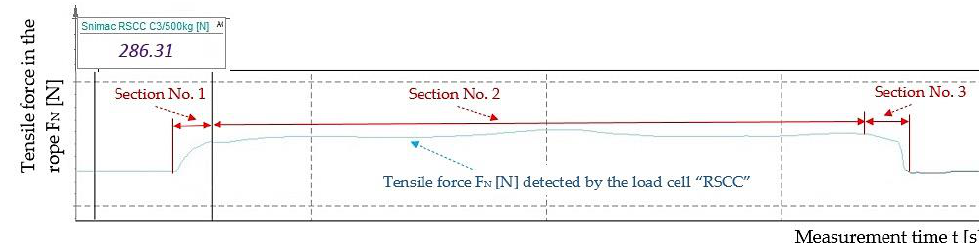
Figure 10. Pulling force waveform of F N measured by RSCC load cell on laboratory equipment. Experimental measurements of the generated pulling force in the cable were carried out on a measuring device (Figure 2) under the static condition of the pulley, i.e., the cable was not subjected to friction in the groove of the rotating pulley. The experimentally meas- ured F oMi forces listed in Table 3 to Table 6 were detected by an IMADA force meter with a measuring range of 0 ÷ 1000 N, a resolution of 1 N and an accuracy of ±2%. The values of the friction coefficients in the V-groove f Mi determined by the indirect method from the measurements carried out on the experimental device (see Figure 2) were calculated from relation (1). Refinement of the measured F oMi force values could be achieved by using a force gauge with more sensitive resolution.